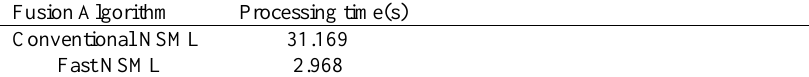
Table 2. Comparison of processing time of fusion